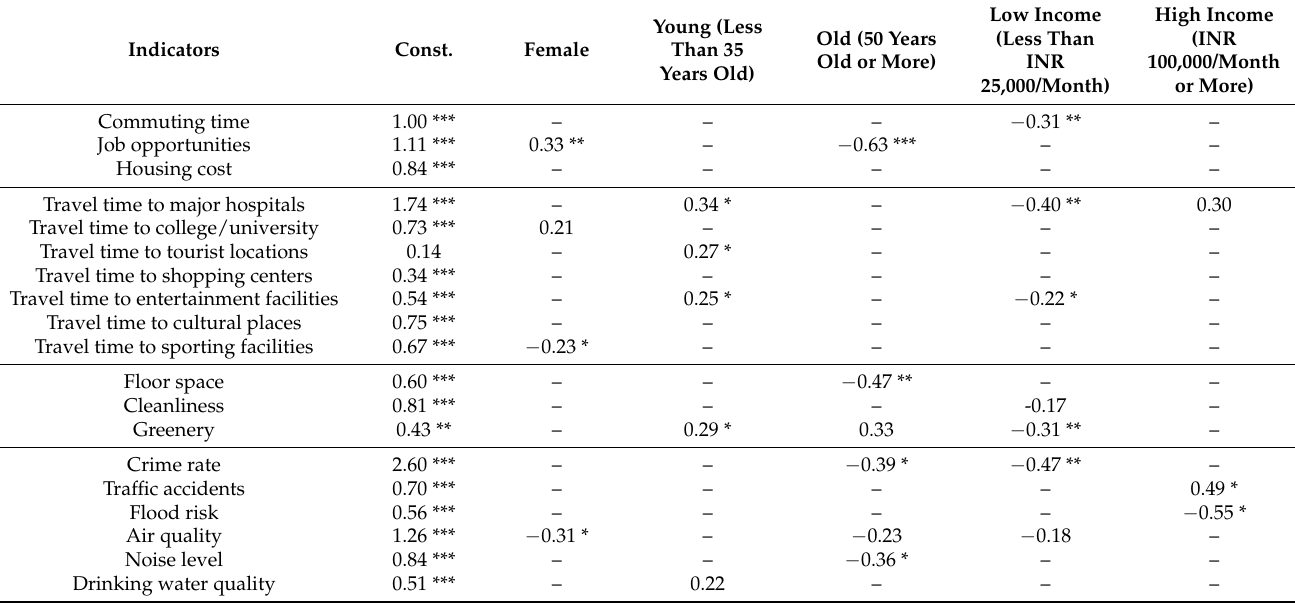
Table 8. Estimated parameters of quality of life (QOL) indicators.